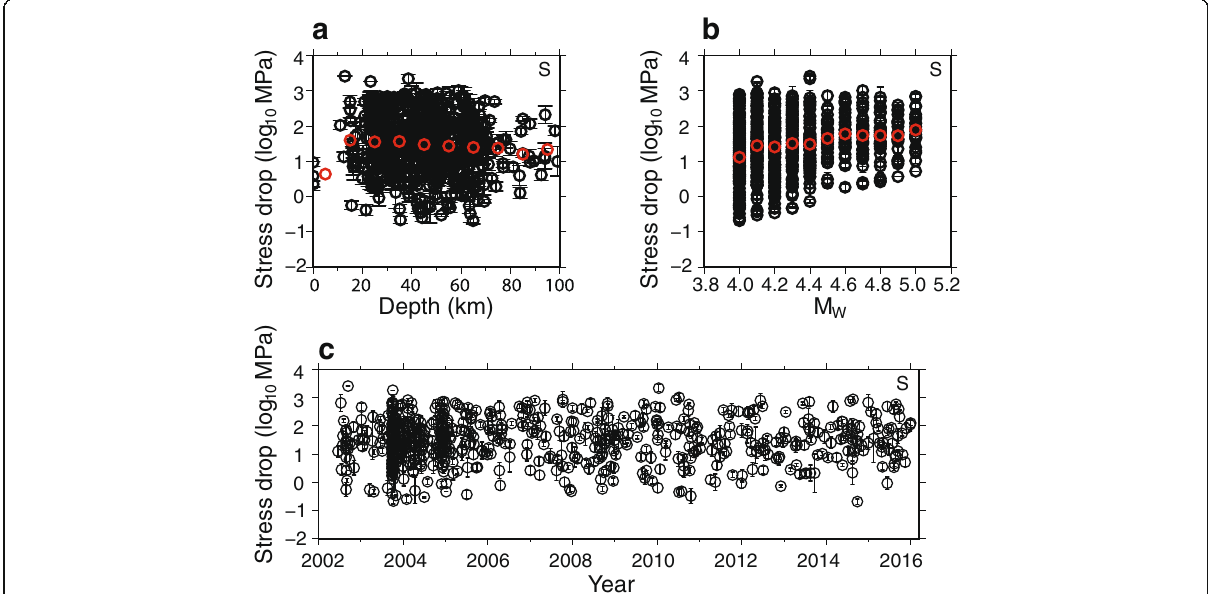
Fig. 6 a Stress drops estimated from S waves as a function of focal depth. The red circles indicate average values for each depth bin for every 10 km. Vertical bars indicate standard errors for individual earthquakes, as calculated from results at individual stations and components. b Stress drops estimated from S waves as a function of magnitude. The red circles indicate average values for individual magnitude bins. Vertical bars indicate standard errors (same as ( a )). c Estimated values of stress drop as a function of